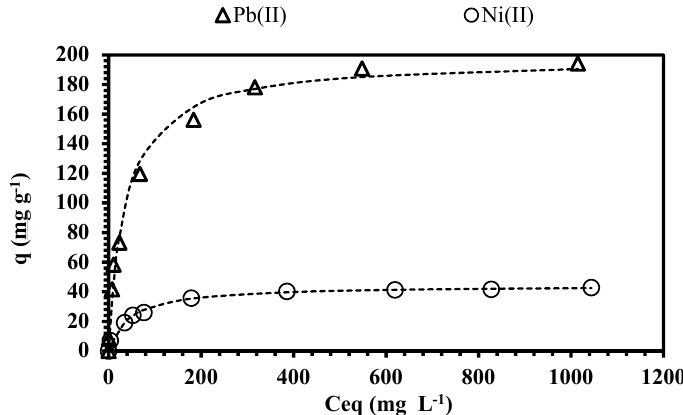
Figure 4. Isotherm plots for lead and nickel removal. (Dashed line: Langmuir model; T : 20 °C; V : 0.01 L; m : 0.01 g; agitation speed: 180 rpm; contact time: 3 h; pH: 4; C 0 : 10–1000 mg L − 1 ; 0.005 M NaNO 3 ).